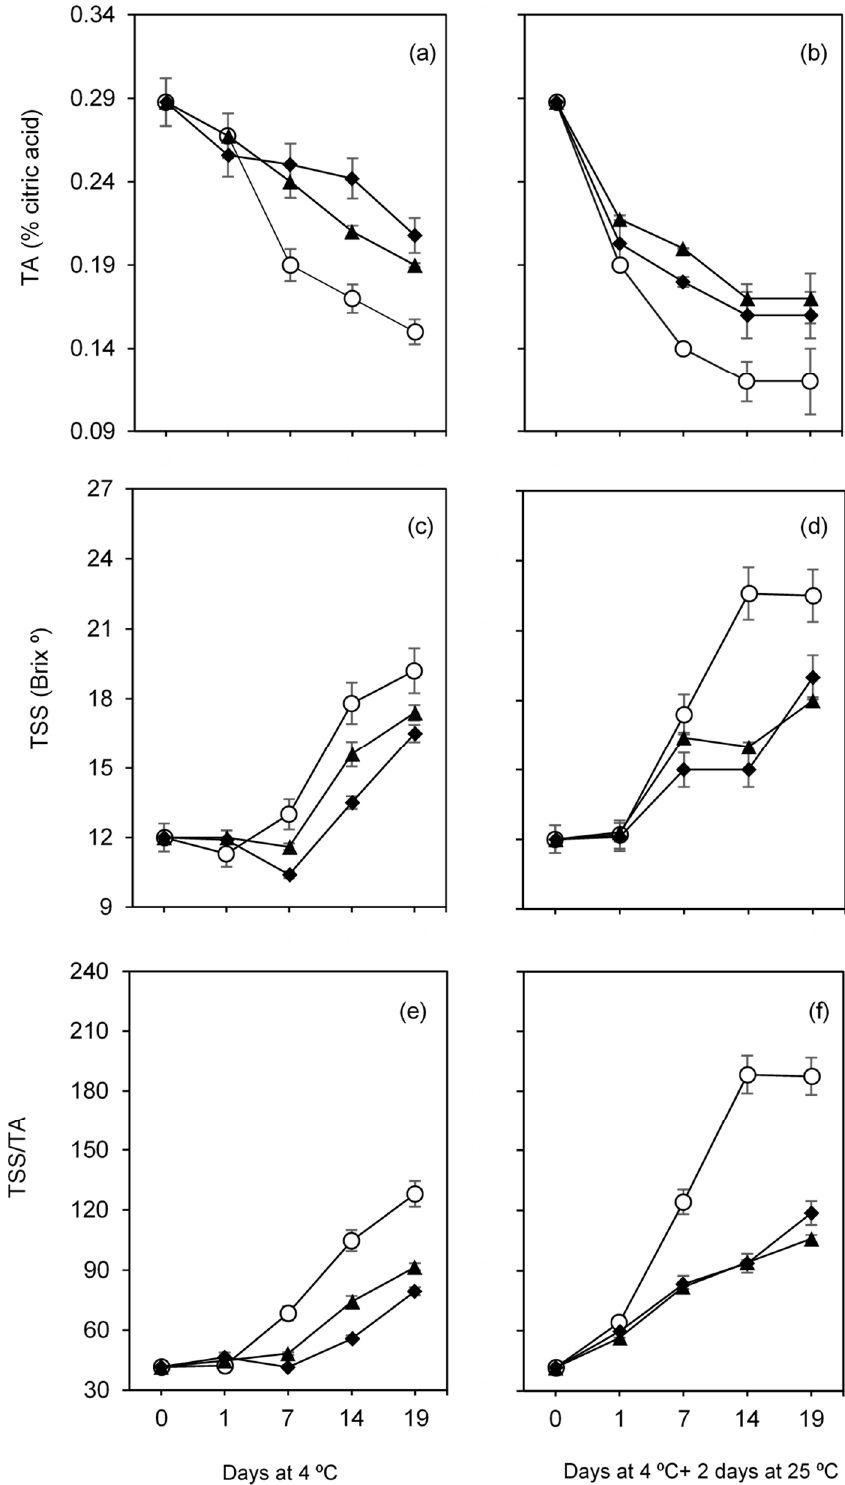
Figure 6. Titratable acidity (TA), total soluble solids (TSS) and maturity index (TSS/TA) of fresh figs ( Ficus carica L. var. ´ Pingo de mel ´ ) coated ( (cid:117) C-OO-TPP and (cid:115) A-OO-Ca) and uncoated ( Ctr), under refrigeration for over 19 days at 4 °C ( a , c , e ) and after being transferred to room temperature for 2 days ( b , d , f ). Each symbol represents each experimental condition, which is associated to a line.